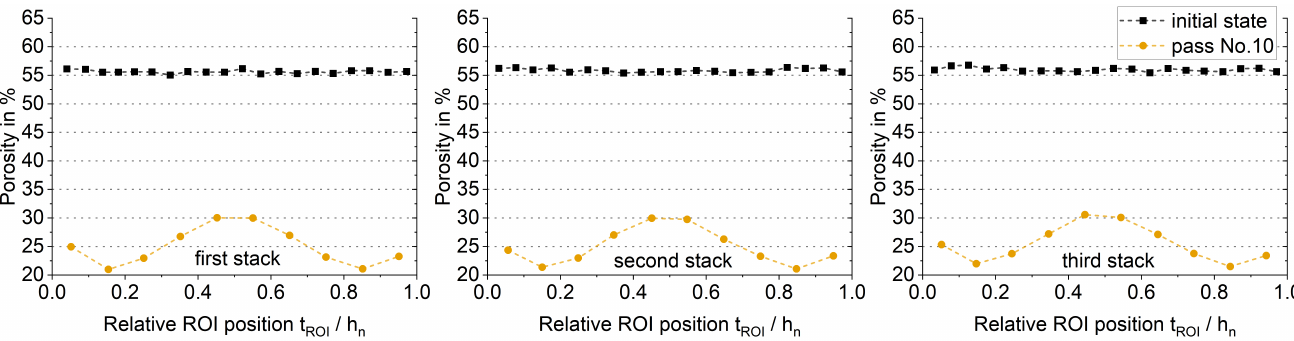
Figure A9. Series II: 20-0.50-10 ( l d / h m ≈ 0.7 − 0.8): Porosity change over relative sample depth (0=upper surface; 0.5= mid-section of sample; 1=lower surface) due to rolling for first, second and third